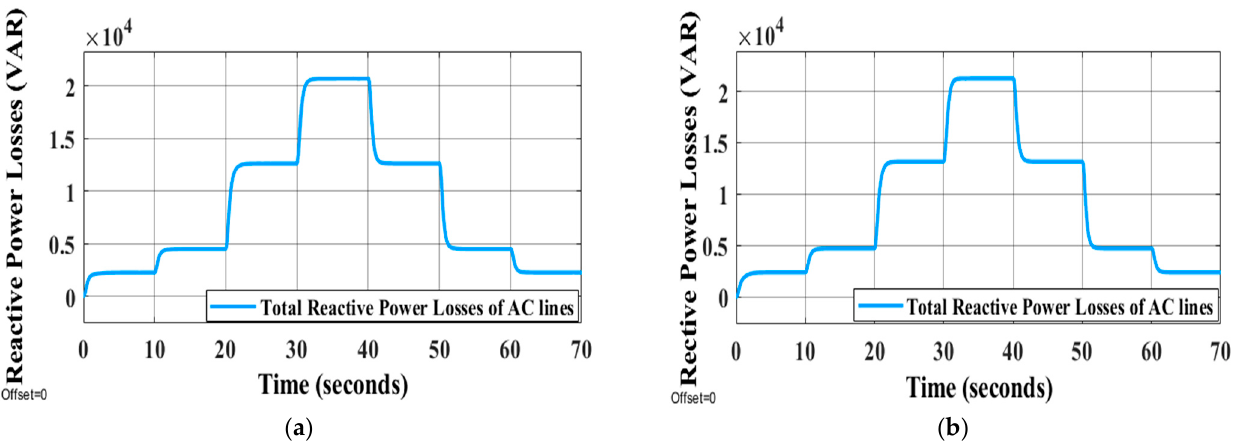
Figure 18. Reactive power losses of AC transmission lines under the changing of load conditions using ( a ) high resistances for DC lines and ( b ) using high resistances for AC lines.